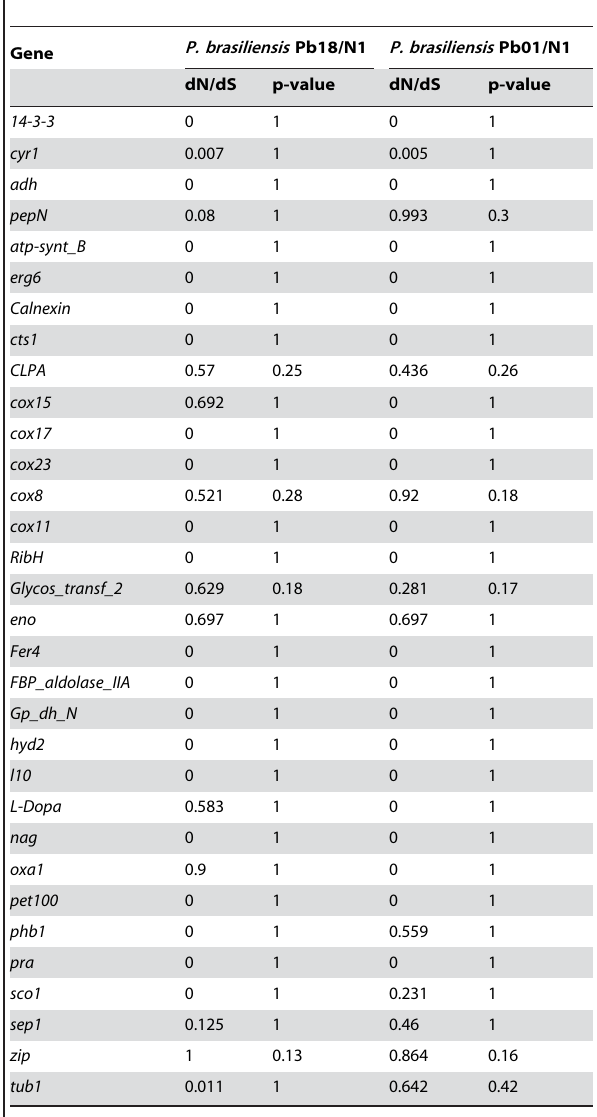
Table 2. dN/dS values for a set of randomly selected genes not related to pathogenesis in the P. brasiliensis lineage.